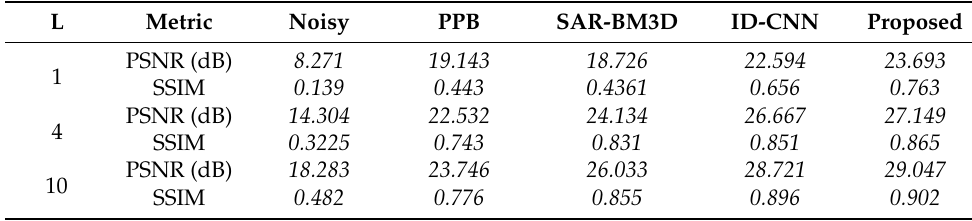
Table 3. The PSNR (dB) comparison of xUnit and M-xUnit with speckle noise level L = 10.